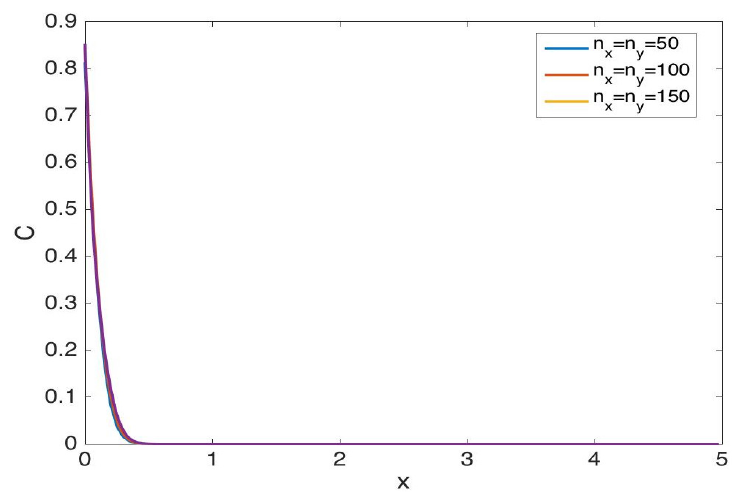
Figure 2. Variation of the adaptive time step size ( ∆ t m ) against its number m of Case 1.